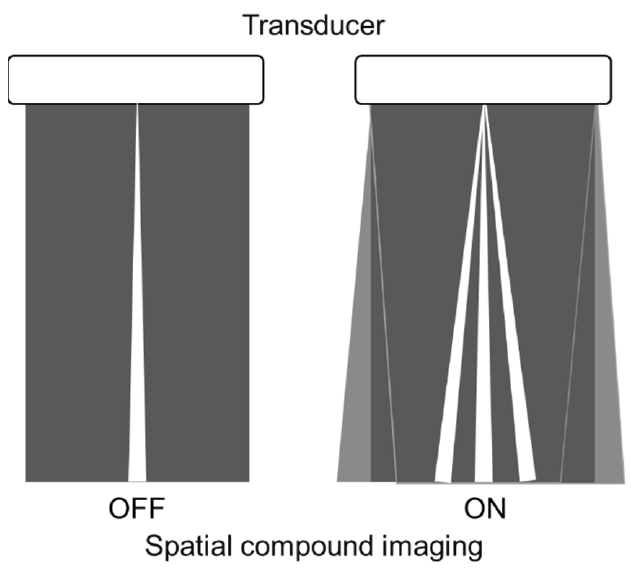
Figure 2. Spatial compound imaging is a method wherein sonographic information is obtained from several different insonation angles and combined to produce a single image.